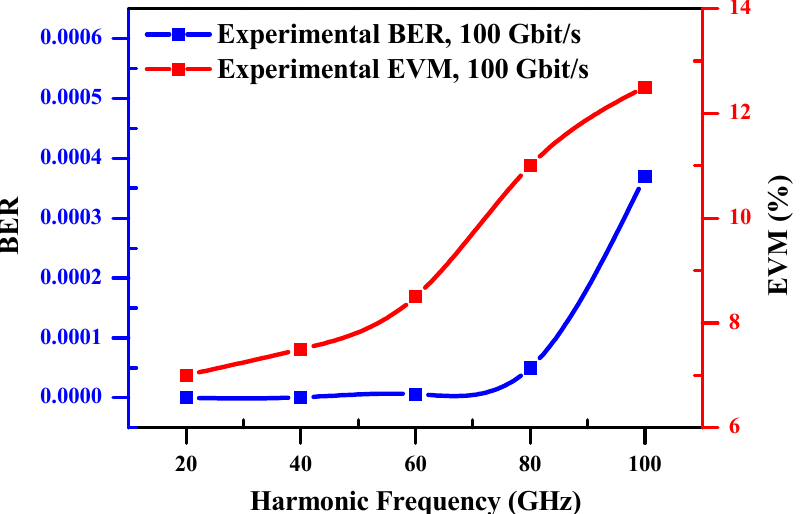
Figure 12. Experimental BER and EVM amounts in opposition to the harmonic frequency for the “AND” signal at 100 Gbit/s in the case of 16-QAM modulation.